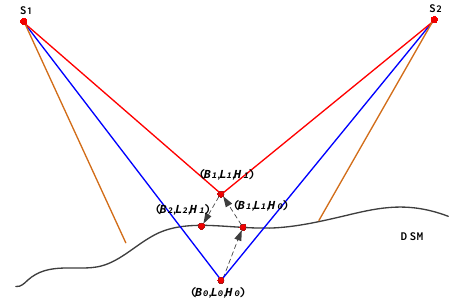
Figure 4. Elevation interpolation from a reference